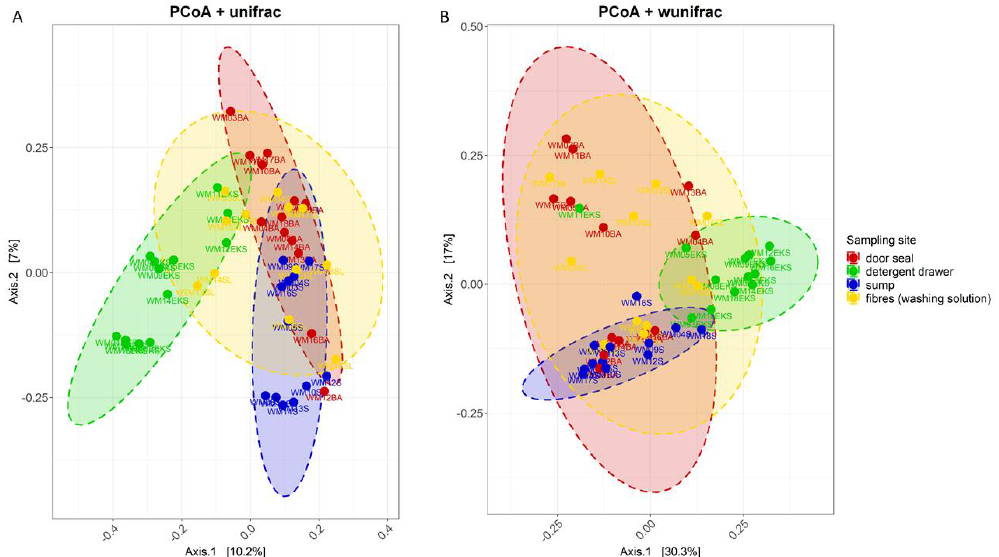
Figure 1. Principal Coordinate Analysis (PCoA) plot of unweighted (A) and weighted (B) UniFrac measures using the 16S rRNA gene sequencing data of 50 analysed washing machine samples. Colour indicates sampling site: door seal (red), detergent drawer (green), sump (blue) and fibres from washing solution (yellow). Ellipses correspond to 95% confidence intervals for each of the four sampling sites.